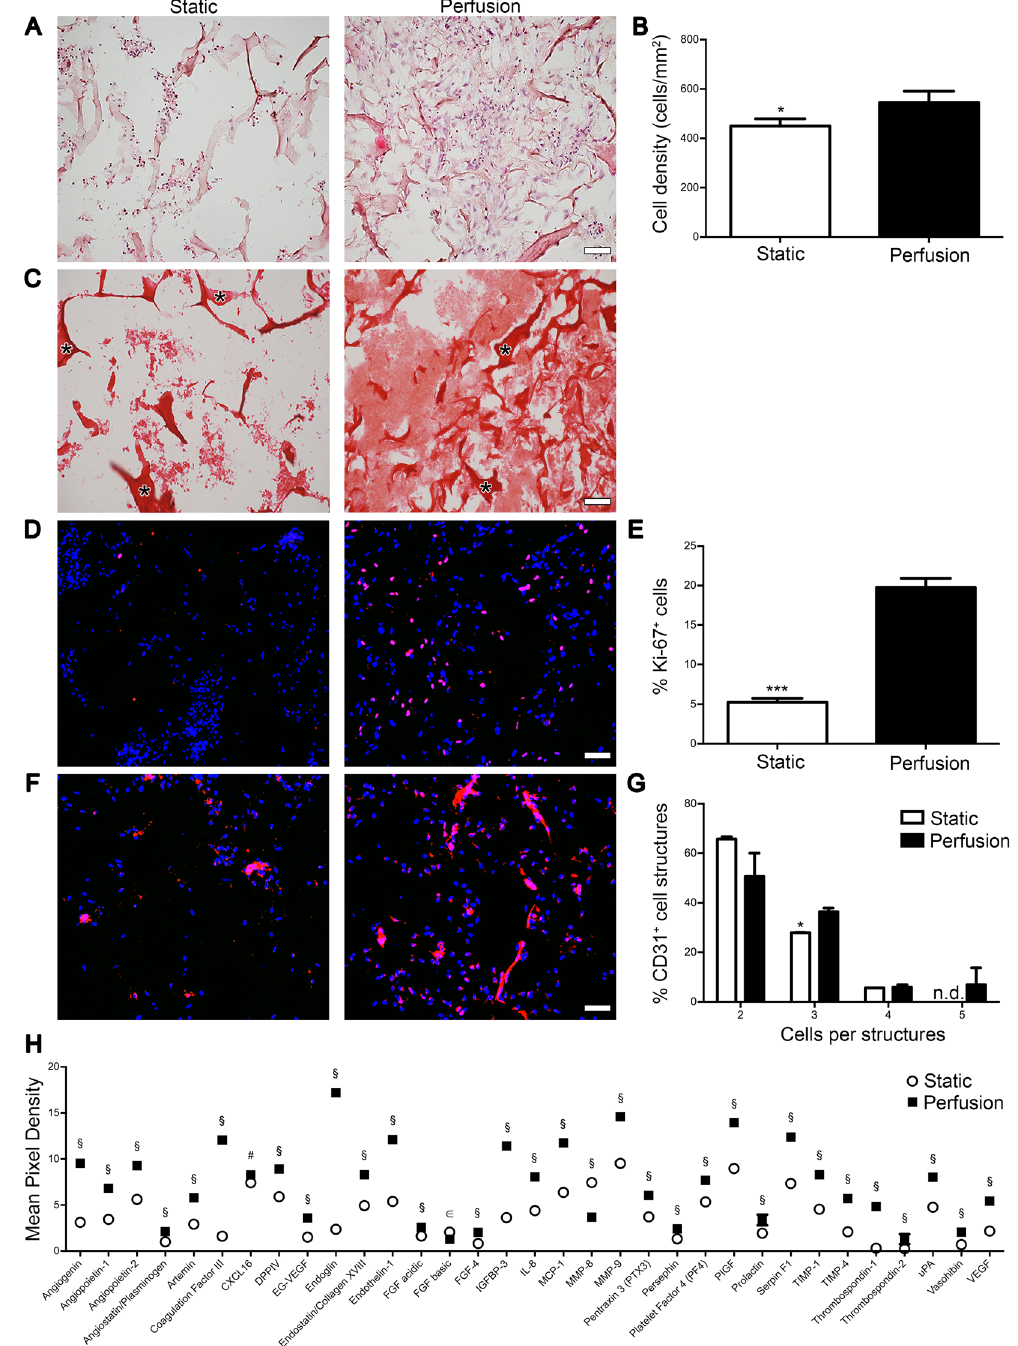
Figure 2. Perfusion increased ECM deposition, in vitro pre-vascularization and pro-angiogenic factor release. Analyses performed on constructs cultured 5 days either in perfusion or static condition. ( A ) Representative H&E images. ( B ) Cell density quantification. ( C ) Representative Picro-Sirius Red images. * Identifies collagen scaffold. ( D ) Representative immunofluorescence images for cell proliferative marker Ki-67 (red). Nuclei were stained with DAPI (blue). ( E ) Quantification of the proliferating cells stained with Ki-67 normalized over the total amount of DAPI. ( F ) Representative immunofluorescence images for endothelial marker CD31 (red). Nuclei were stained with DAPI (blue). ( G ) Percentage of endothelial cell structures. * p < 0.05, *** p < 0.001. n.d. = not detectable. (n donor = 3). ( H ) Human angiogenesis proteome profiler array showing the release of angiogenic factors. Data are presented as mean pixel density normalized on DNA. § = *** p < 0.001; # = ** p < 0.01; ϵ = * p < 0.05. Scale bar: 50 μ m. (n donor =